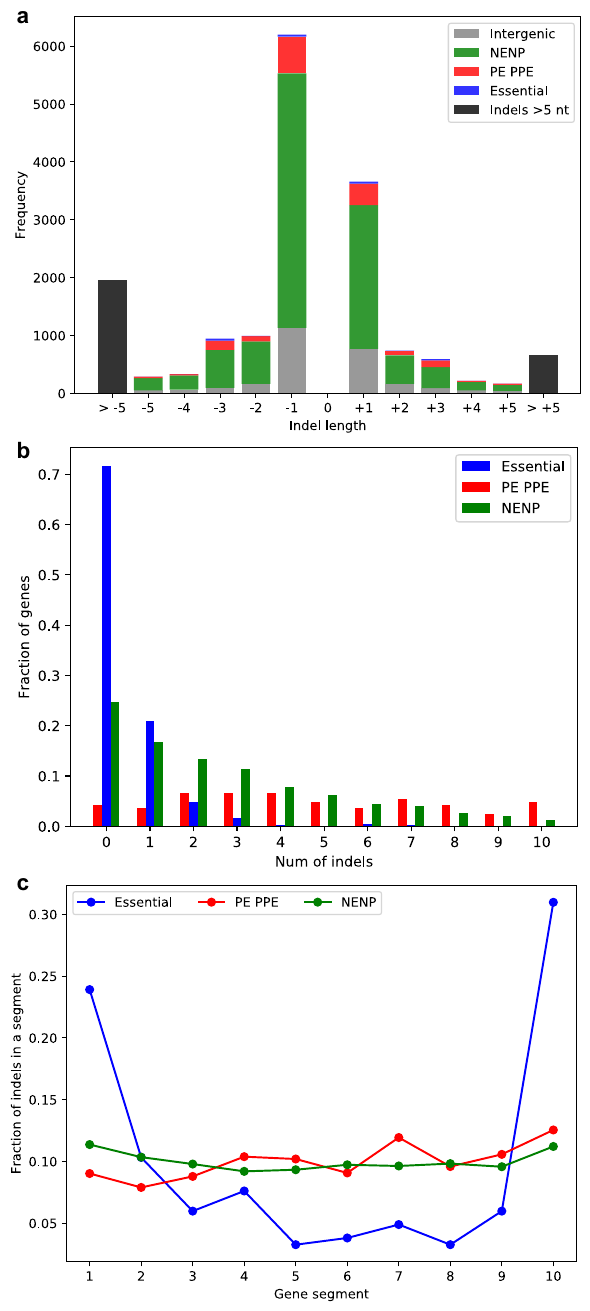
Fig. 2b, for H scores: 0.31, 6.06e-5, Fig. 2c). In contrast, the low- complexity gene fraction of essential genes and non-essential non-PPE genes was uncorrelated with the number of unique indels in these genes (Pearson correlation coef fi cients for LC and H scores for essential genes: 0.028 and 0.035, respective two-tailed p values: 0.55 and 0.45; Pearson correlation coef fi cients for LC and H scores for nonessential non-PPE genes: 0.053 and 0.061, respective two-tailed p values: 0.002 and 0.0003). Moreover, the number of unique indels was strongly correlated with gene length for PE-PPE genes (Fig. 3, Pearson correlation coef fi cient and two- tailed p value: 0.877 and 7.69e-54), moderately correlated for non-essential non-PPE genes (Pearson correlation coef fi cient and two-tailed p value: 0.464 and 1.12e-40), and weakly correlated for essential genes (Pearson correlation coef fi cient and two-tailed p value: 0.222 and 1.51e-6). Thus, the abundance of low sequence